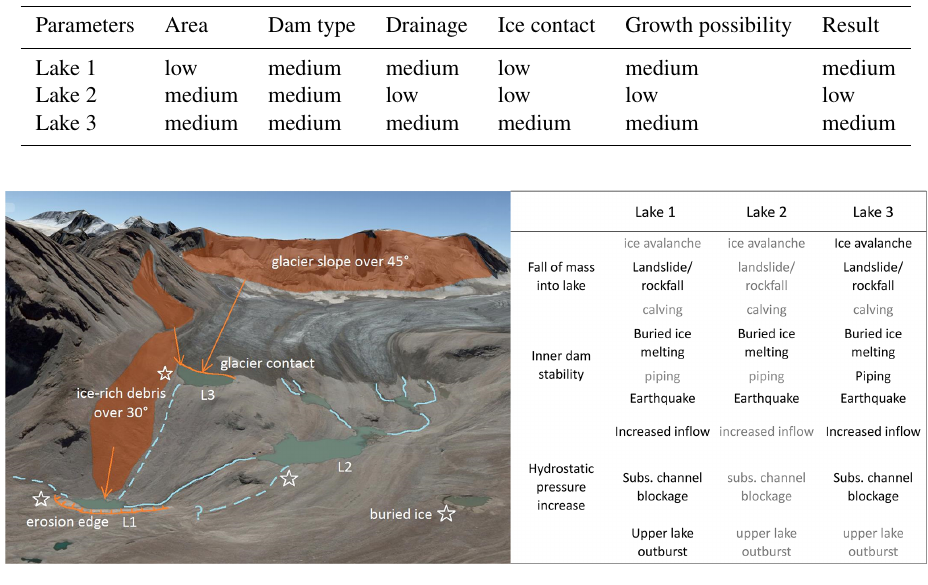
Figure 9. Geomorphological conditions and potential triggers of lake outburst at the Adygine ice-debris complex. View from the north (Google Earth,